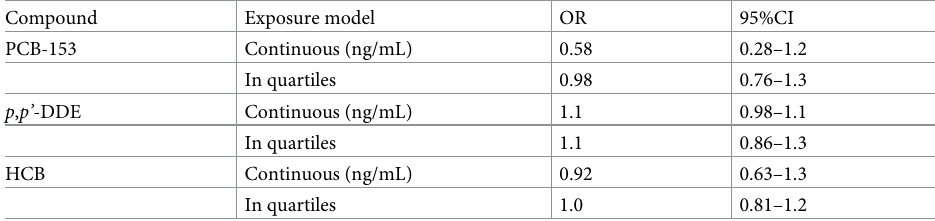
The median maternal serum concentrations of PCB-153 was 0.45 ng/ml for the cases (range 0.03–1.7 ng/ml) and 0.47 ng/mL for the controls (0.03–4.0 ng/mL), of p , p’ -DDE 1.1 ng/ ml for cases (0.05–34 ng/ml) and 1.1 ng/mL for controls (0.05–20 ng/mL), and of HCB 0.19 ng/ml for cases (0.01–3.1 ng/ml) and 0.19 for controls (0.01–10 ng/ml). Levels of compounds in cases and controls, and numbers of men in the different exposure quartiles, are shown in Table 2. When using the exposure variables as continuous variables, one ng/mL increase in PCB- 153 levels corresponded to a 42% lower odds [OR of 0.58 (95%CI: 0.28–1.2)] of being a case (Table 3). Correspondingly, one ng/mL increase in p , p’- DDE gave a 10% higher odds [OR of 1.1 (95% CI: 0.98–1.1)] of being a case, whereas one ng/mL increase in HCB gave an 8% lower odds [OR of 0.92 (95%CI: 0.63–1.3)] of being a case (Table 3). When having the POP levels divided in quartiles, one unit increase in quartiles of PCB-153 corresponded to a 2% lower odds of being a case [OR 0.98 (95%CI: 0.76–1.3)]. For p , p’- DDE, one unit increase in quartiles corresponded to a 10% higher odds of being a case [OR 1.1 (95% Table 3. Odds ratios of a son with cryptorchidism depending on one unit increase in maternal levels (continuous or in quartiles) of POPs, unadjusted for levels of the other two POPs. Compound